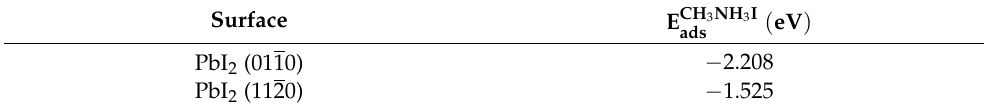
Figure 4. DFT-calculated atomic structures of MAI adsorption on the 2H PbI 2 surface of ( a ) (0110) and ( b ) (1120) planes. Pb, I, C, N, and H atoms are illustrated using lavender, brown, blue, gray, and white colors, respectively. Table 1. Adsorption energy of CH 3 NH 3 I on PbI 2 (0110) and PbI 2 (1120) surfaces.